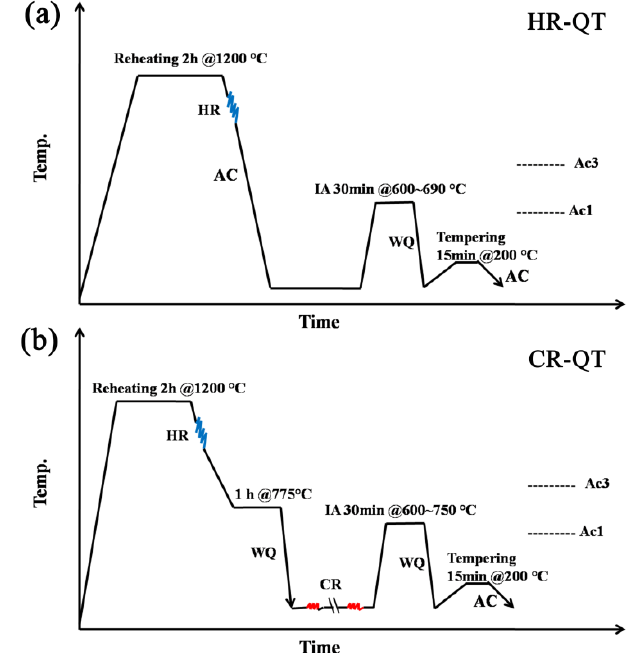
Figure 2. Graph of the thermo-mechanical treatment of quenching and tempering (Q&T) process used ( a ) for the hot-rolled and quenching and tempering(HR-QT) steels, ( b ) for the cold-rolled and quenching and tempering(CR-QT) steels (AC: air cooling, IA: intercritical annealing, WQ: water quenching).